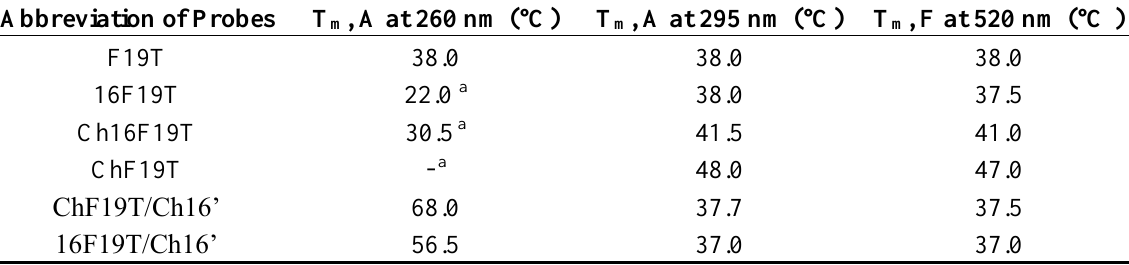
Table 2. Melting temperatures (T m ) for quadruplex-forming oligonucleotide probes determined from dependences of absorbance at 260 nm or 295 nm and from fluorescence of FAM at 520